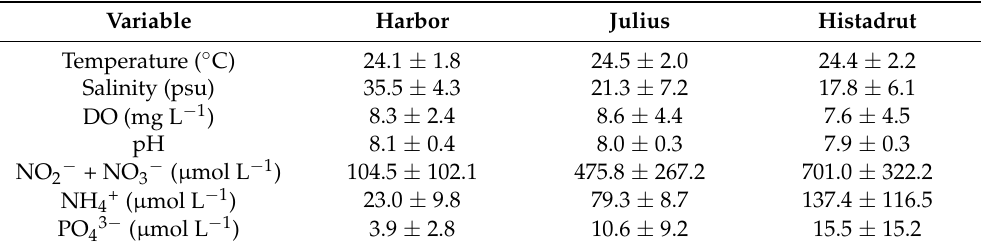
Table 1. Summary table showing the main surface water physiochemical and chl- a characteristics at the Kishon Estuary sampling stations between 2002–2021. The data shown are the averages and their corresponding standard deviation. DIN = NO 3 − + NO 2 − + NH 4+